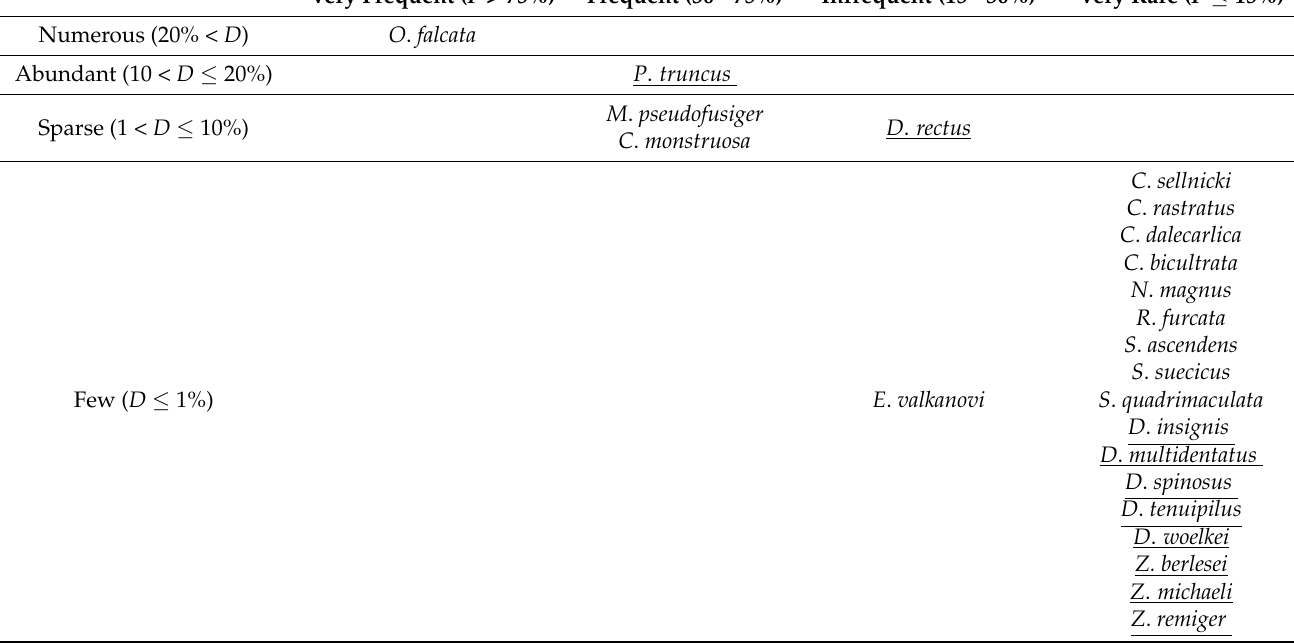
Table 2. Status of occurrence of species new to Norway: Oribatida (Italic font) and Mesostigmata (Italic underlined font) in broadleaf forest in Eastern Norway; D —dominance (percentage of specimens of a particular species in the average abundance), F —frequency (percentage of the samples where the species was present). Very Frequent ( F > 75%) Frequent (30 − 75%) Infrequent (15 − 30%) Very Rare ( F ≤ 15%) Numerous (20% < D